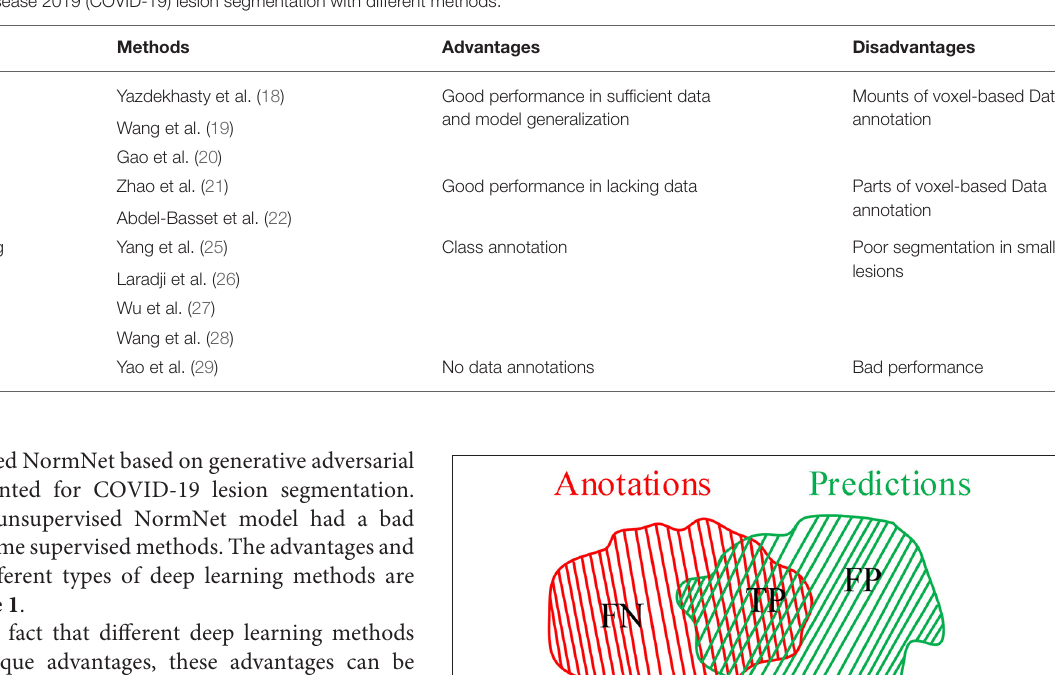
TABLE 1 | Coronavirus disease 2019 (COVID-19) lesion segmentation with different methods.